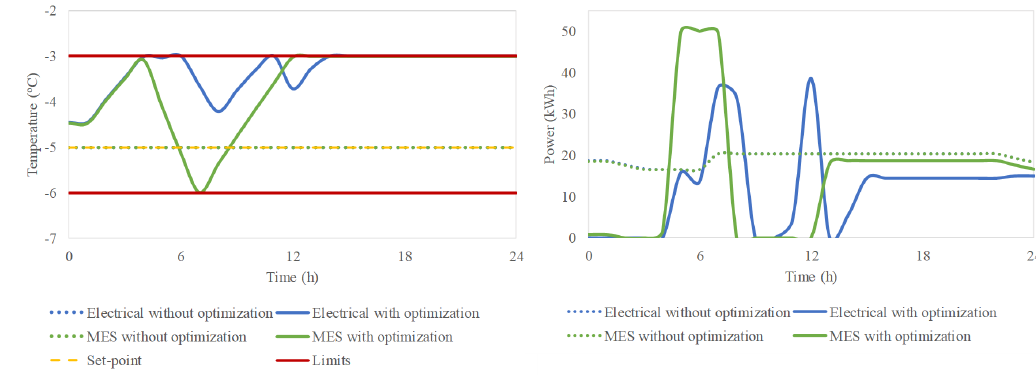
Figure 16. Temperature and power consumed by the refrigeration systems of the supermarket.